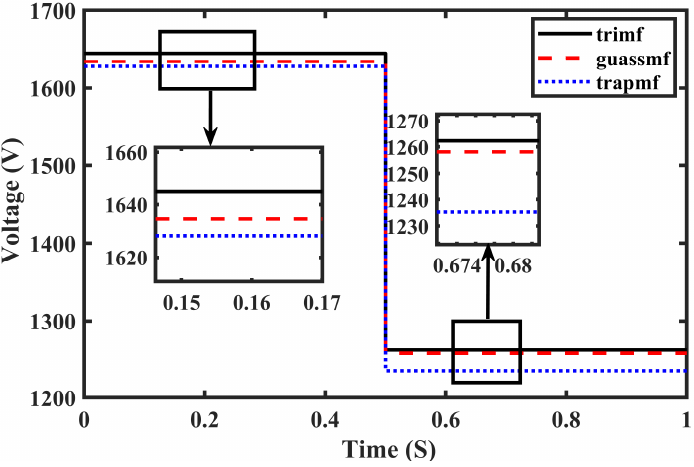
Table 2. Comparison of reference voltage prediction for various NF techniques.